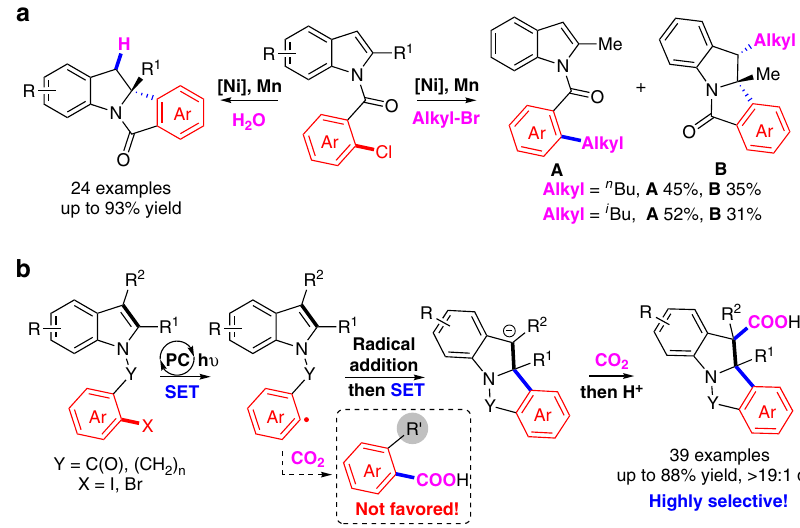
39 examples up to 88% yield, >19:1 d.r.